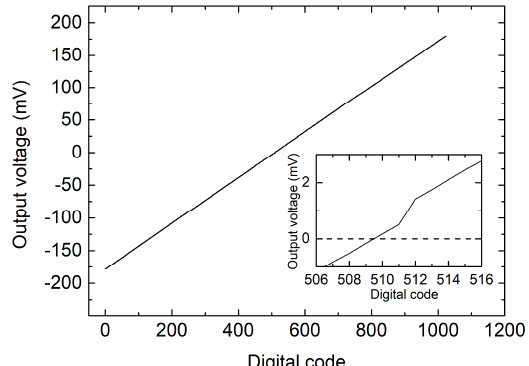
Figure 6. Output voltage as a function of the digital code that controls the differential component of the heater currents, properly trimmed to cancel the output offset.